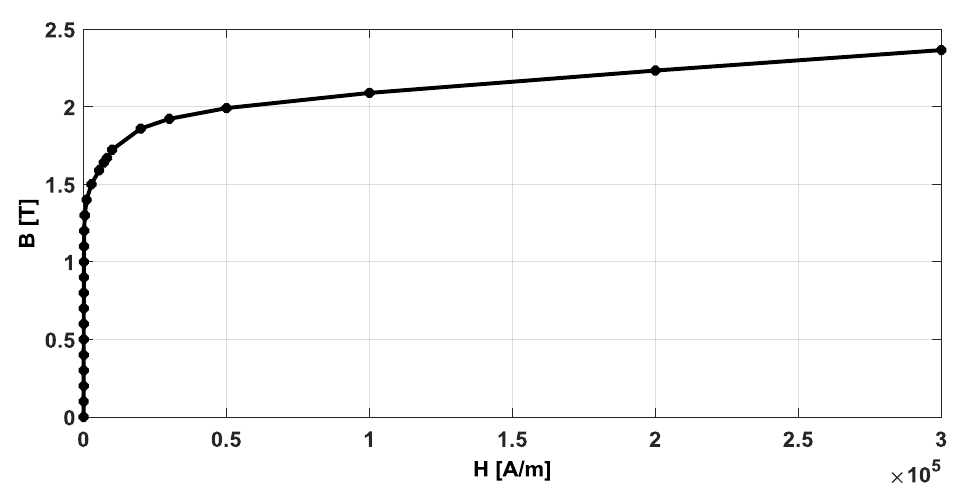
Figure 5. Magnetization curve for M270-35A.